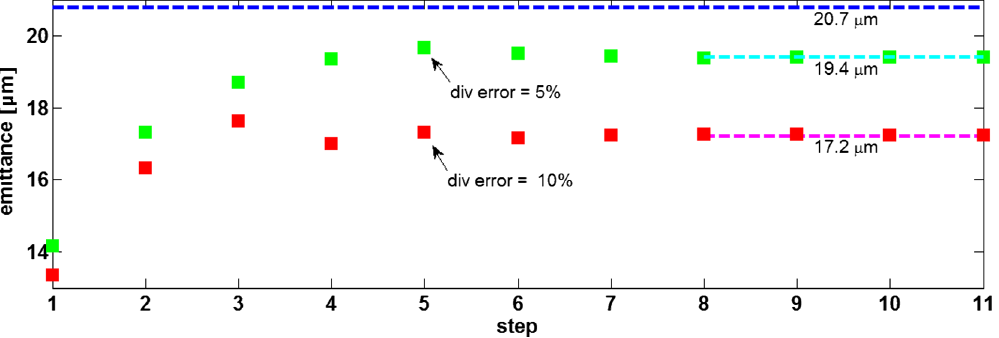
FIG. 7. Plot showing convergence of emittance for a round beam with high space charge ( K ¼ 7 : 02 (cid:3) 10 (cid:1) 4 ) when there are 5% and 10% errors in the divergence sampled at the focal length f 1